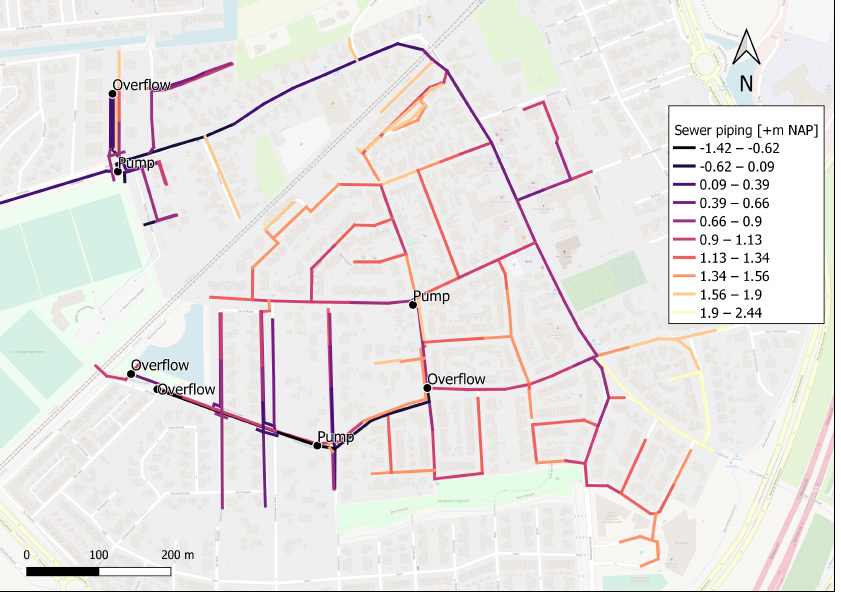
Figure 3. Locations of important structures in the studied area and the level of sewer